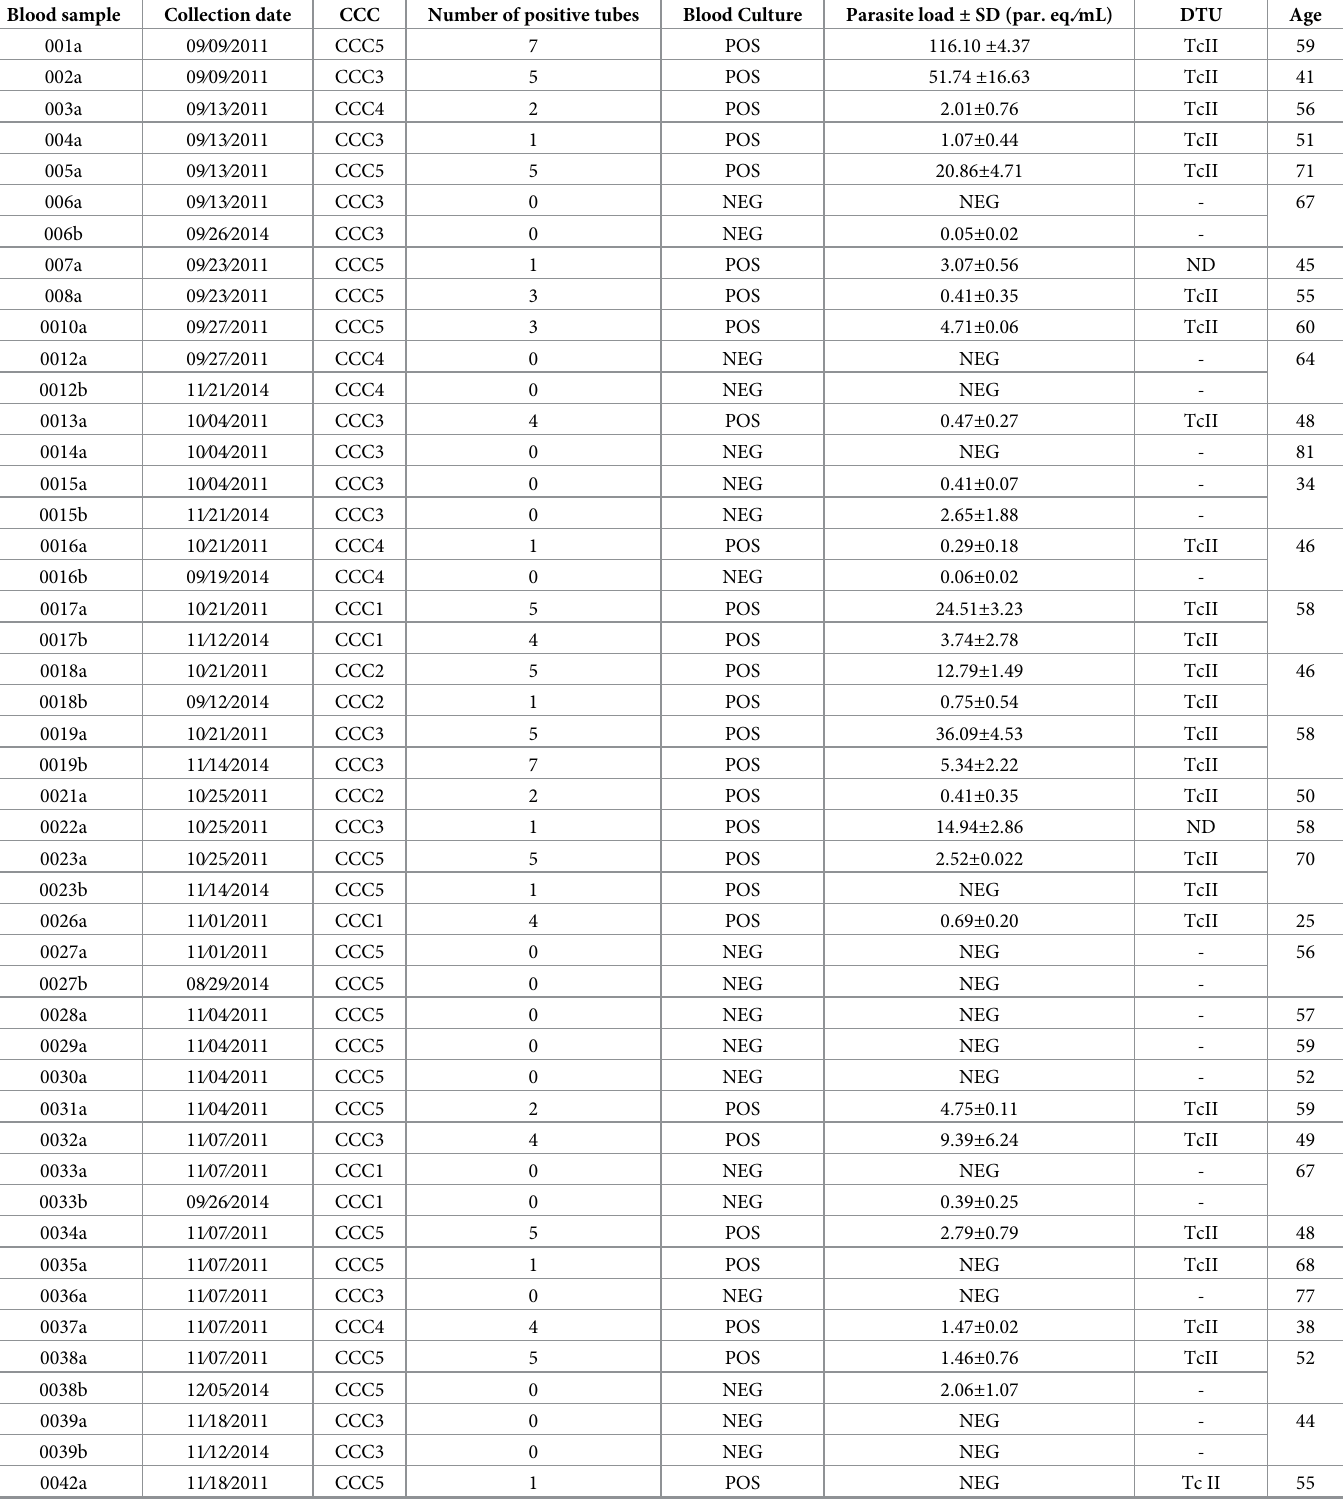
Table 2. Comparison of blood culture, T . cruzi genotype and parasite load in patients with different degrees of chronic Chagas disease cardiomyopathy. Blood